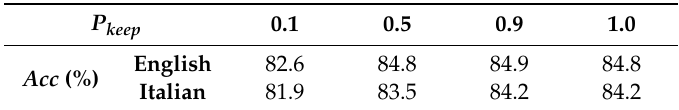
Table 14. Testing accuracy obtained by di ff erent dropout 1 .